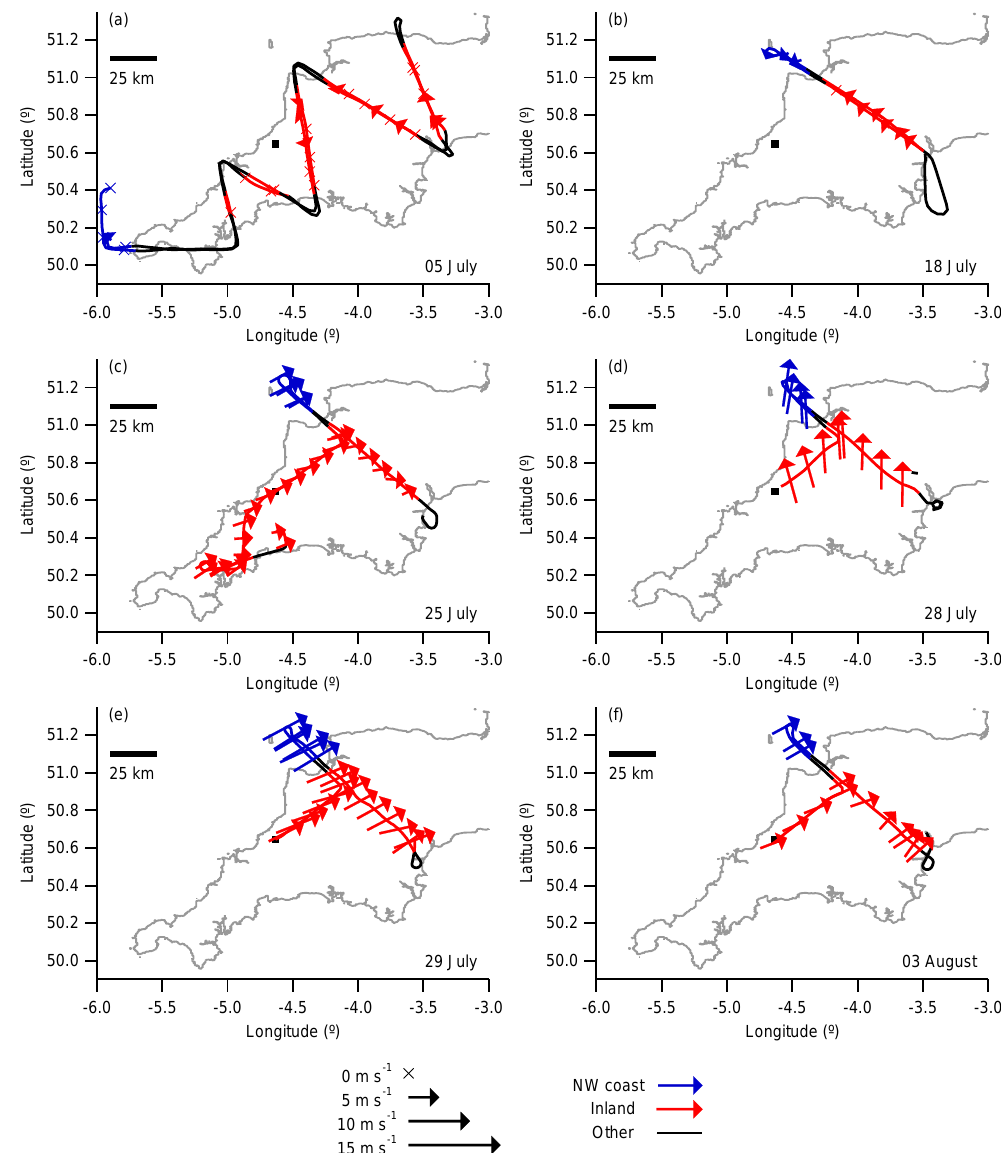
Figure 2. Spatial location of the below-cloud aerosol runs on each case study flight. Panels (a – f) show the six case study flights. The arrow markers show the measured wind speed and direction. The black square shows the location of the Davidstow ground